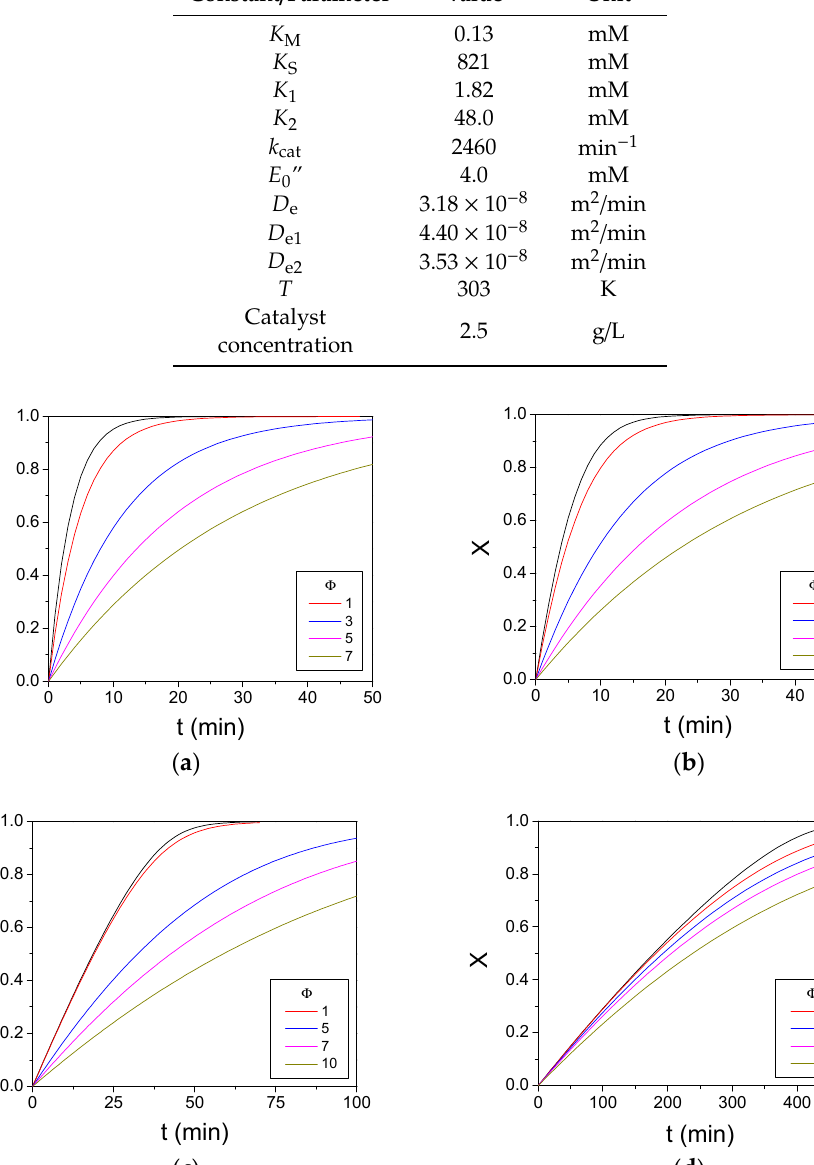
Figure 2. Reaction progress for the hydrolysis of penicillin G by soluble (black line) and immobilized PGA (color lines) for catalysts with different initial PenG concentrations (S 0 /K M ) and Thiele moduli ( Φ ): ( a ) S 0 /K M = 0.1; ( b ) S 0 /K M = 1.0; ( c ) S 0 /K M = 10; ( d ) S 0 /K M = 100.